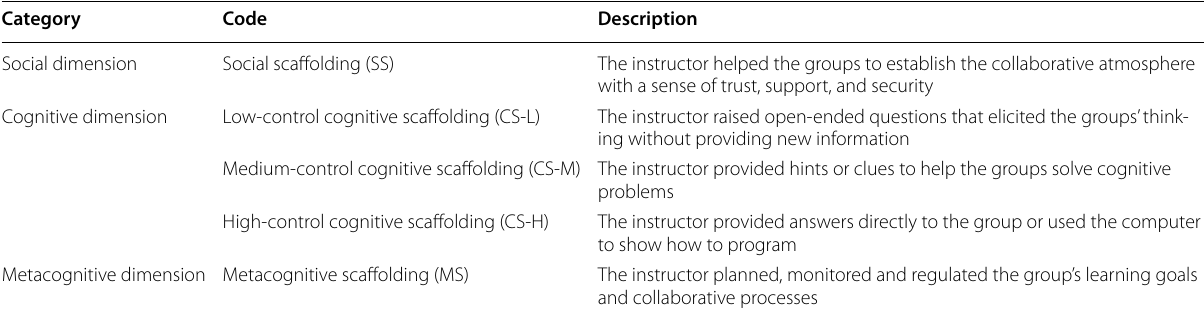
Table 2 The coding framework for instructor scaffoldings (c.f. van de Pol et al., 2019)